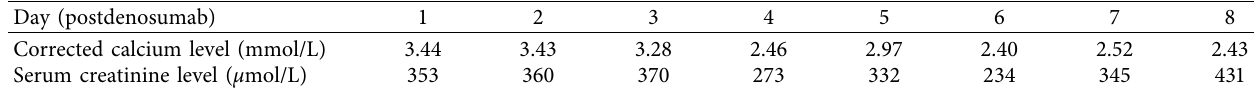
Table 3: Serum calcium level after administration of subcutaneous denosumab.